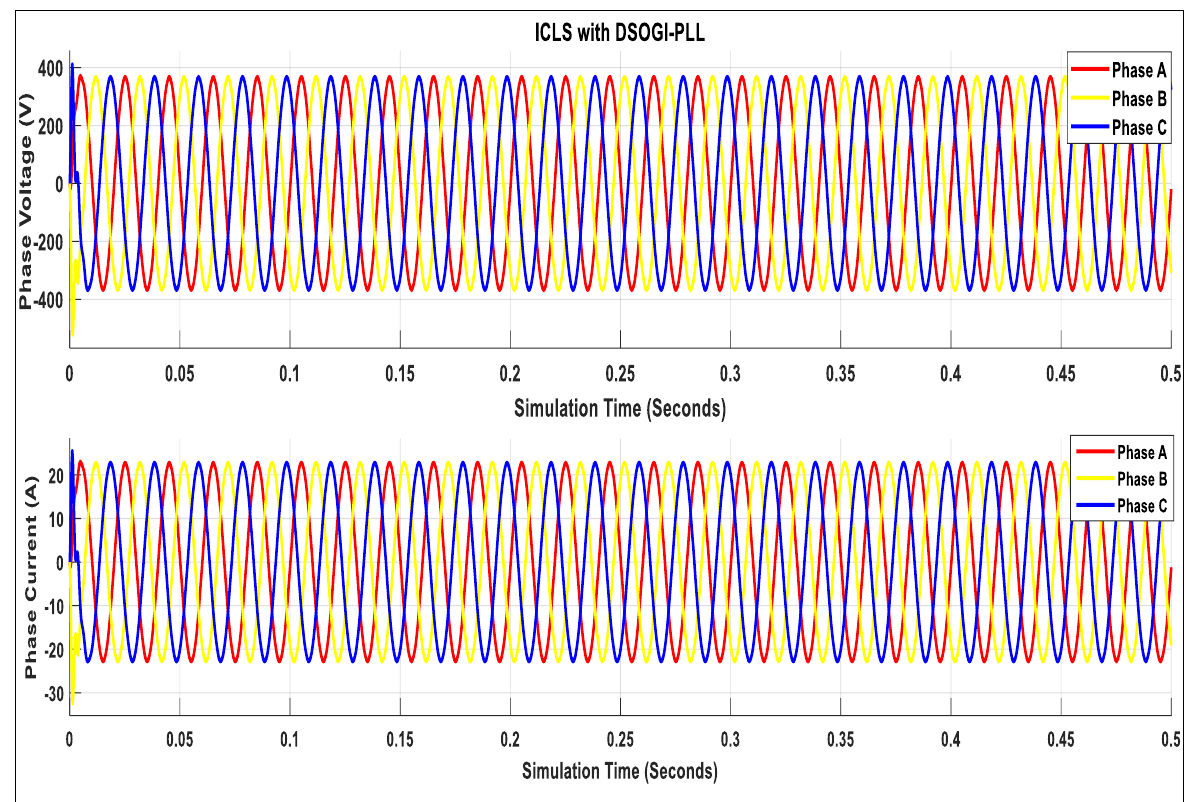
Figure 10. The THD case study 1 performance results with ICLS-DSOGI-PLL.